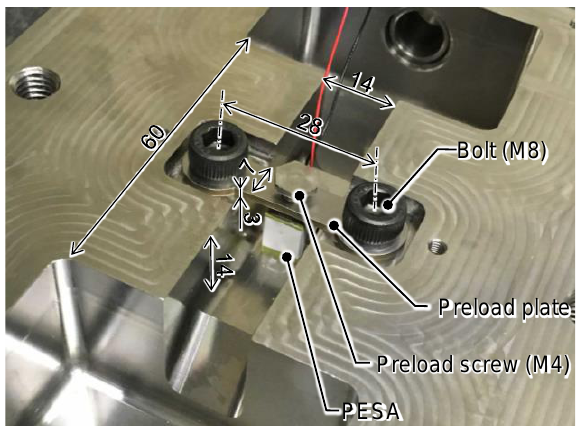
Figure 2. Photograph of the preloaded PESA and cooling channel structure.